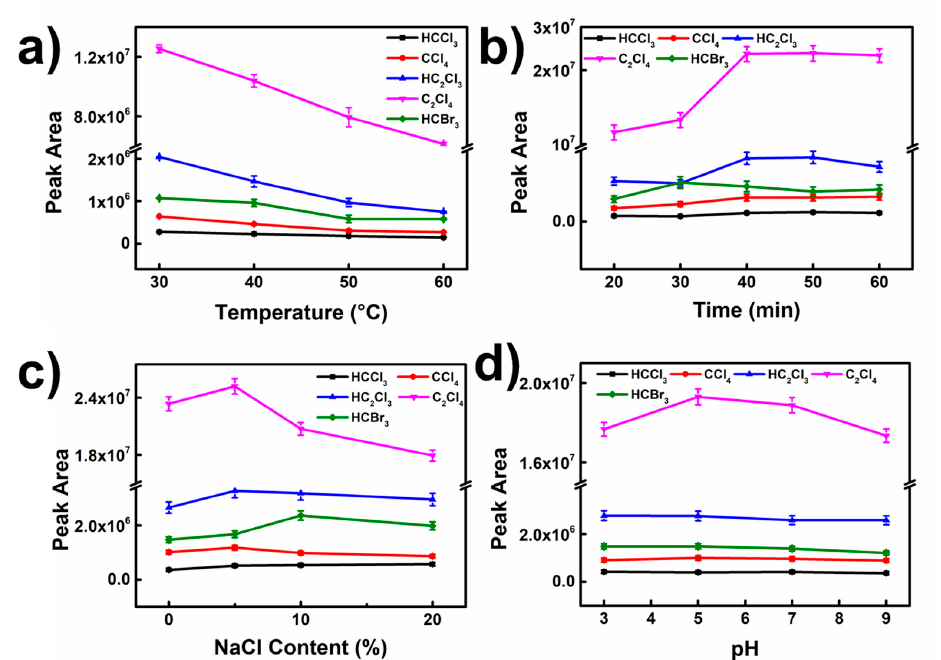
Figure 5. Effect of extraction temperature ( a ), extraction time ( b ), salt concentration ( c ), and pH ( d ) on extraction efficiencies of PAA/N-SPCs coating for SPME of VHCs.